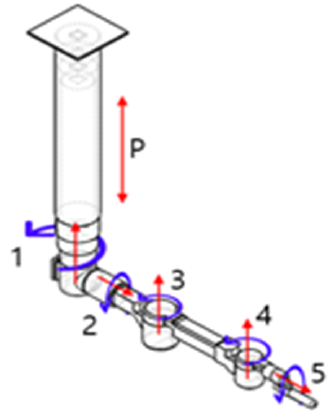
Figure 2. CAD robot manipulator [23,24].